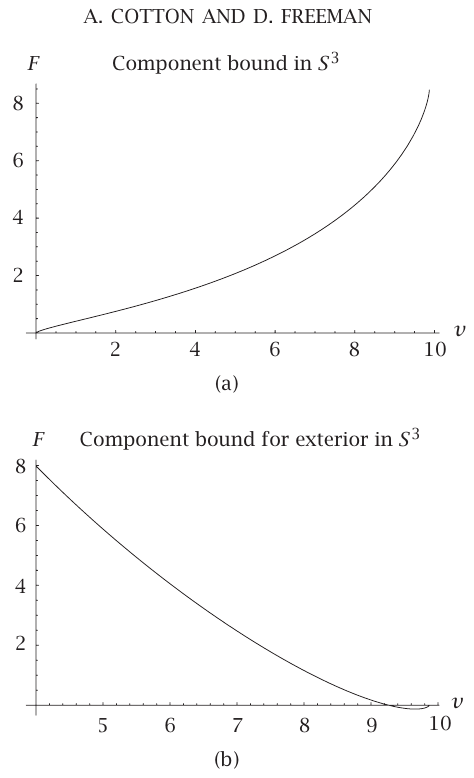
Figure 5.1 . (a) A Mathematica plot of F s (v) for v ∈ [ 0 ,π 2 ] suggests that F s (v) is positive in this interval, and thus each region of a double bubble enclosing equal volumes has one component. (b) A Mathematica plot of (cid:12) F s (v) for v ∈ [ 4 ,π 2 ] suggests that (cid:12) F s (v) is positive for v < 9, and thus the exterior of an equal-volume double bubble is connected when it is at least 10 percent of the total volume of S 3